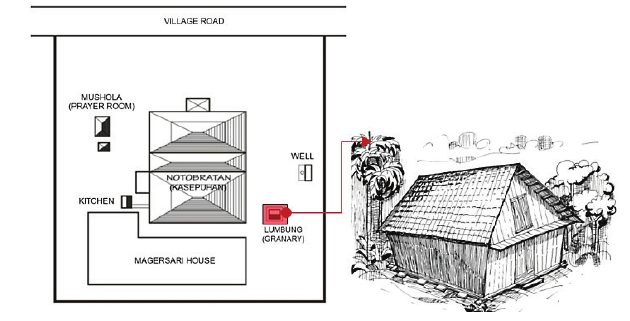
Figure 8. The granary has changed into a warehouse (source: Survey, 2017)